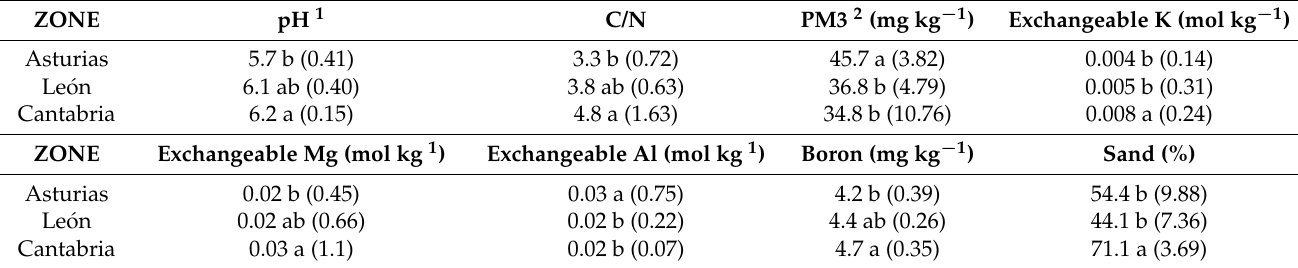
Table 3. Mean values of the soil properties with significant differences according to the